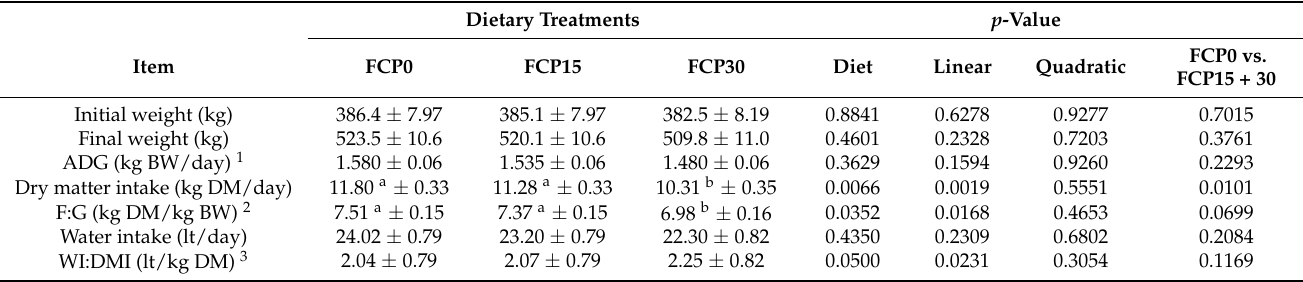
Table 2. Least square means ± standard errors of animal performance according to dietary treatments. Dietary Treatments p -Value